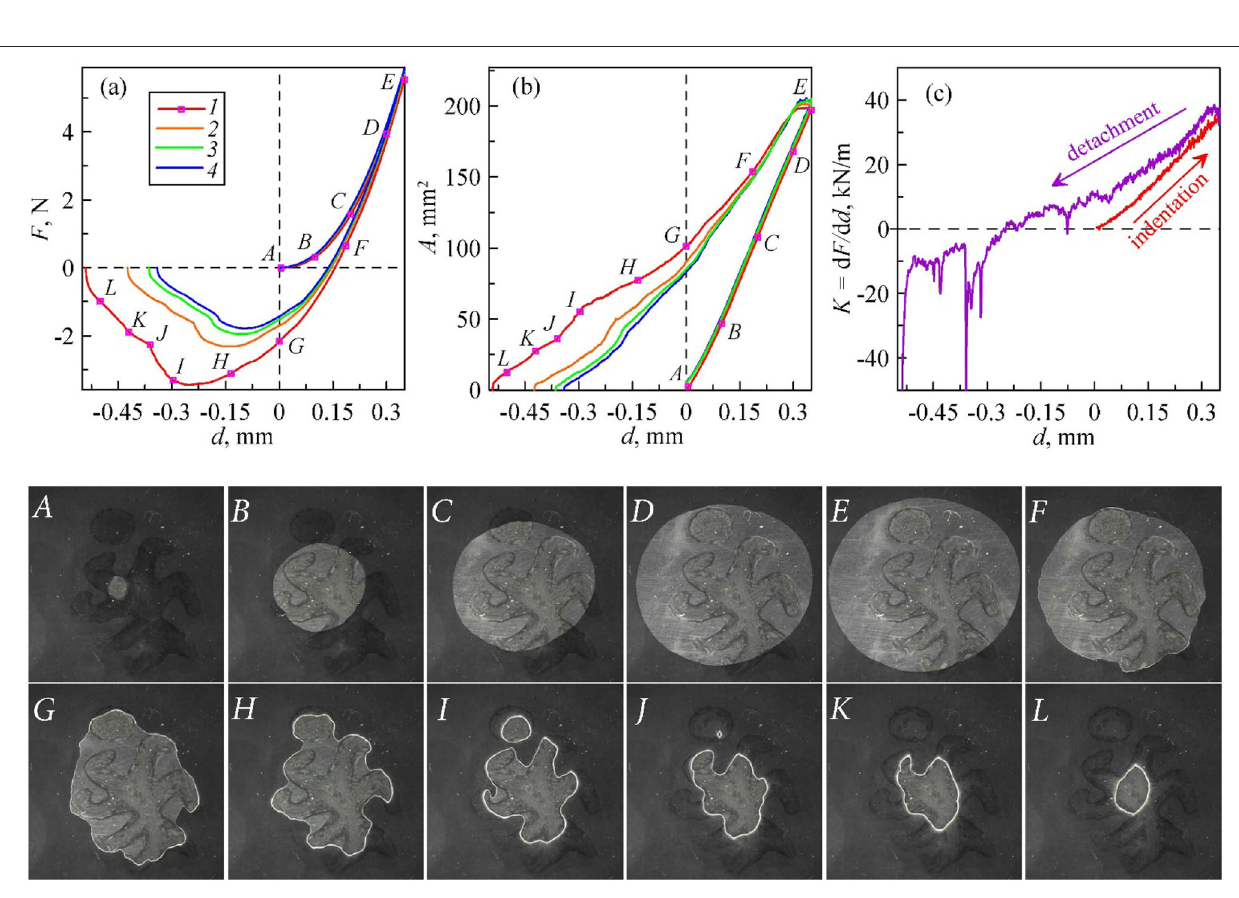
Frontiers in Mechanical Engineering | www.frontiersin.org